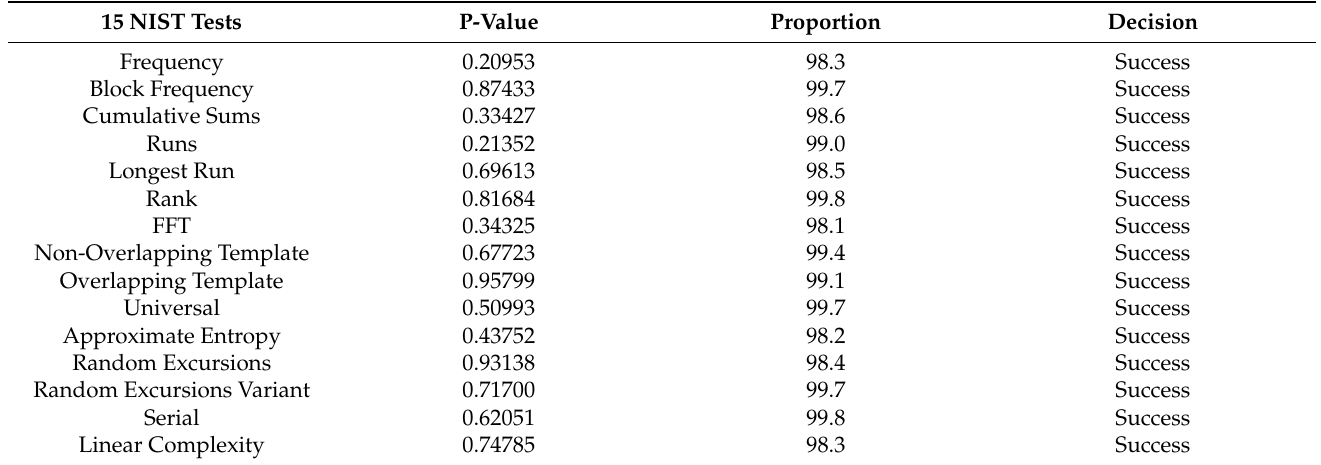
Table 2. Randomness test results of the final obtained